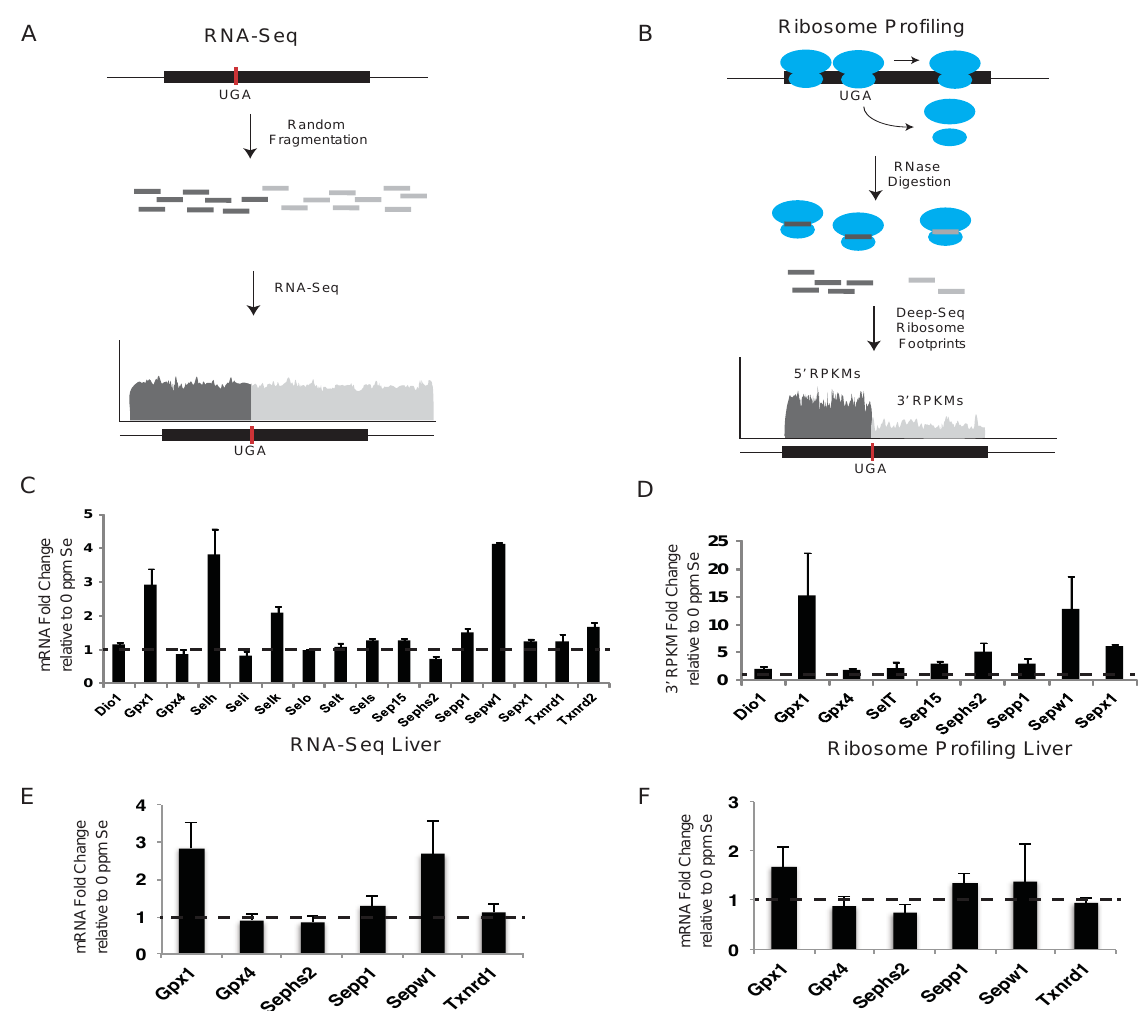
Figure 1. RNA-Seq and ribosome profiling of selenoprotein mRNAs. ( A ) and ( B ) show conceptual illustrations of RNA-Seq and ribosome profiling experiments, respectively. A representative selenoprotein mRNA is shown with the position of the UGA-Sec codon indicated by the vertical red bar. Randomly sheared ( A ) or ribosome protected ( B ) mRNA fragments are shown in dark or light grey to indicate whether they are positioned 5 1 or 3 1 of the UGA-Sec codon. ( C ) The histogram shows the fold-change in liver sequence reads per kilobase per million mapped reads (RPKM) in mice fed diets supplemented with 0.1 ppm Se (0.1 Se) relative to those fed unsupplemented diets (0 ppm Se). Dashed line across the histogram indicates a fold change value of 1 (no difference). ( D – F ) Same as in ( C ) for liver ribosome protected fragments, Liver qPCR and lung qPCR, respectively, with the exception that in ( D ) the RPKM values were determined only for the portion of the selenoprotein mRNA located 3 1 of the UGA-Sec codon. Standard deviations were calculated by the Propagation of Error